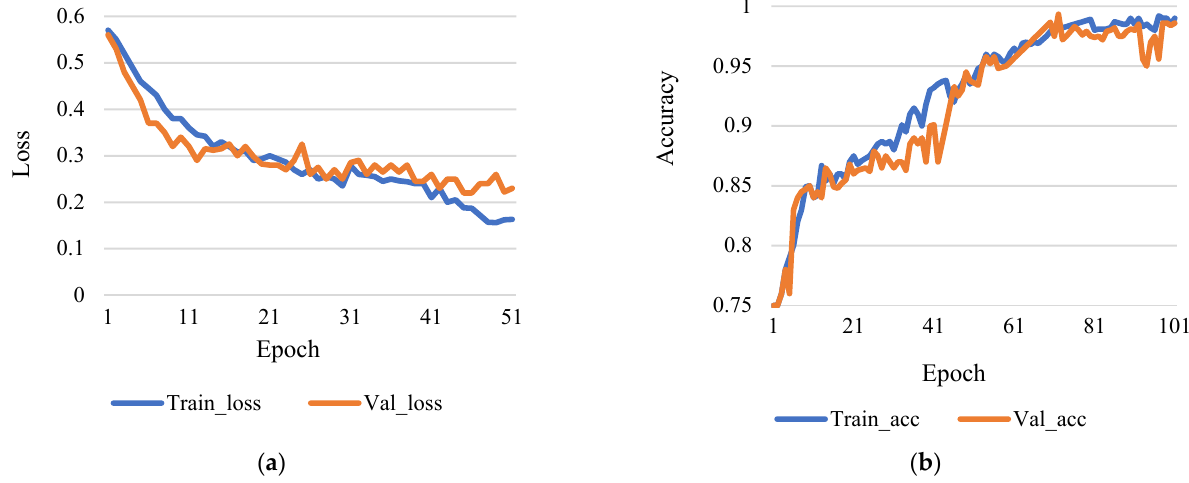
Figure 8. ( a ) Training loss vs validation loss (rate of learning 0.01 and epoch 50). ( b ) Training accuracy vs validation accuracy (rate of learning 0.01 and epoch 50).